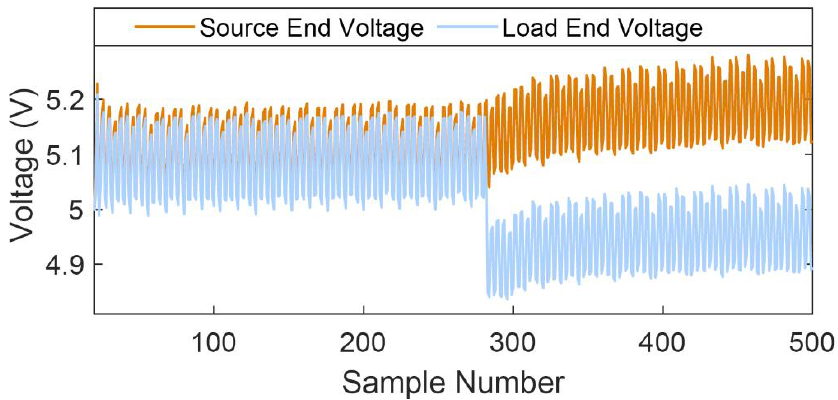
Figure 7. Event 2: data used for series arc fault analysis—voltages at the source and load ends.